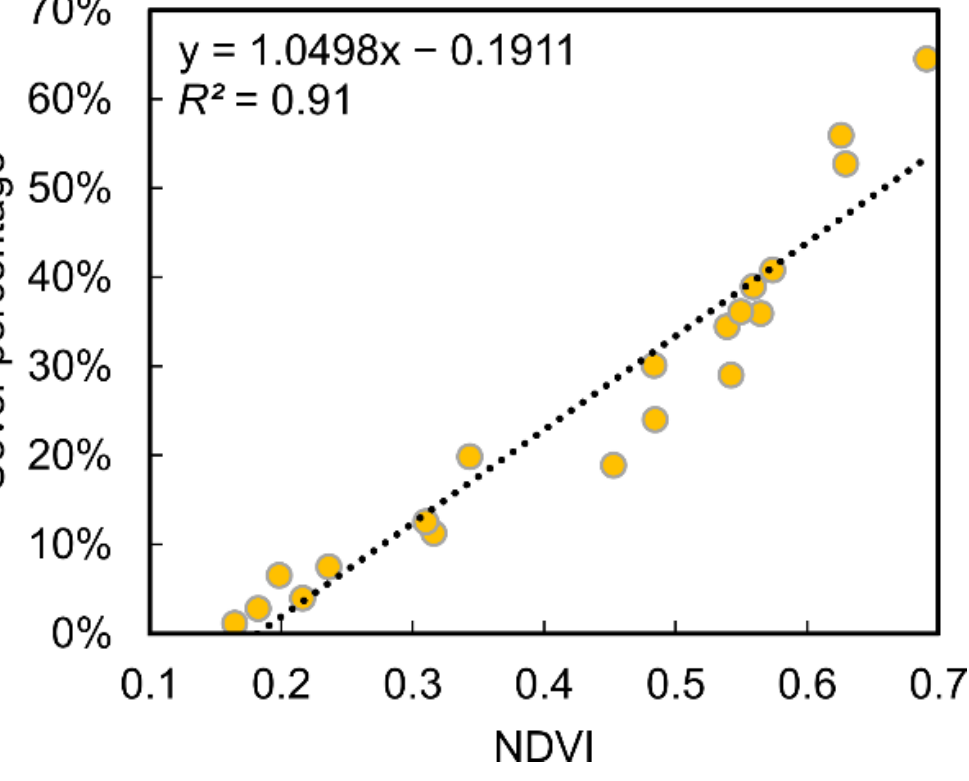
Figure 7. Linear correlation between water hyacinth cover percentage and mean normalized differ- ence vegetation index (NDVI) of the water channels. Values from May to October 2018 to 2021.